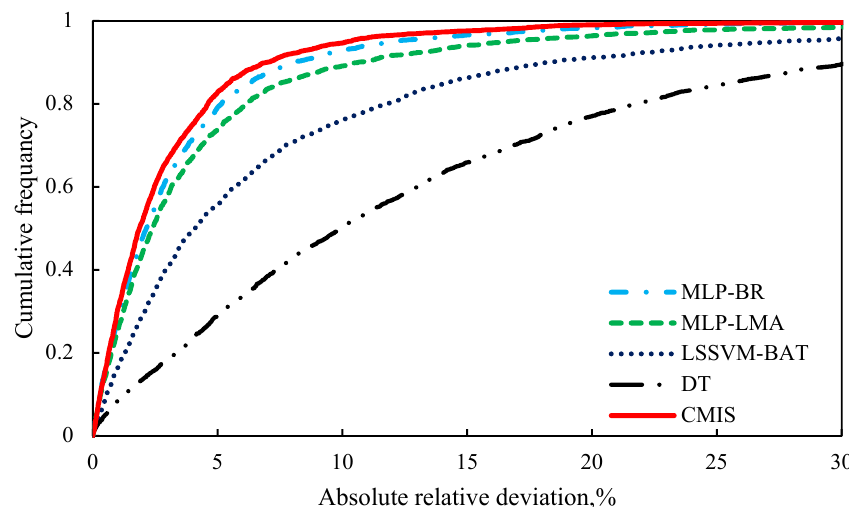
Figure 7. Comparison between absolute average relative deviation (AARD, %) of different models for estimation of viscosity of ILs based on Model (II).